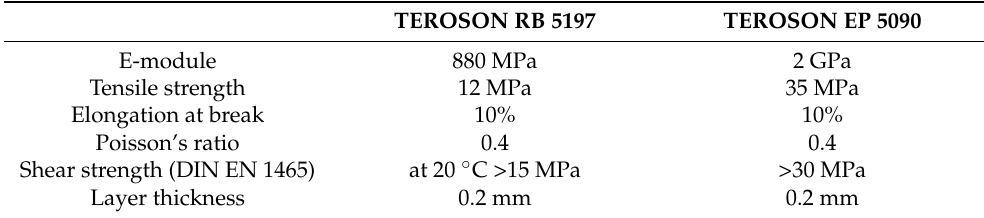
Table 6. Selected properties of adhesives, given by adhesive producer (Henkel AG & Co., KGaA, Düsseldorf,